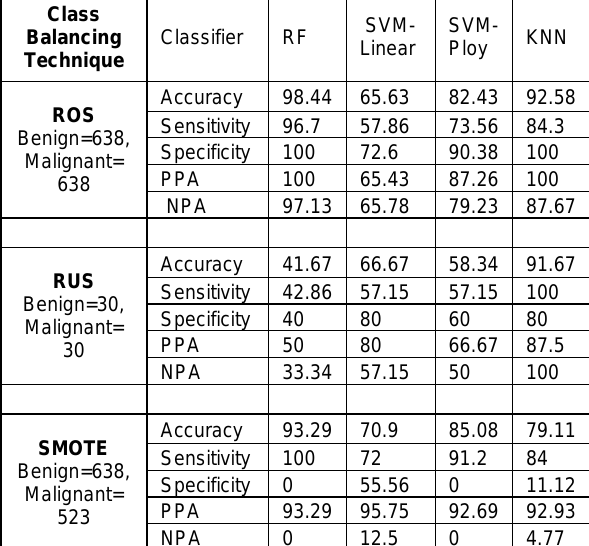
Class Balancing